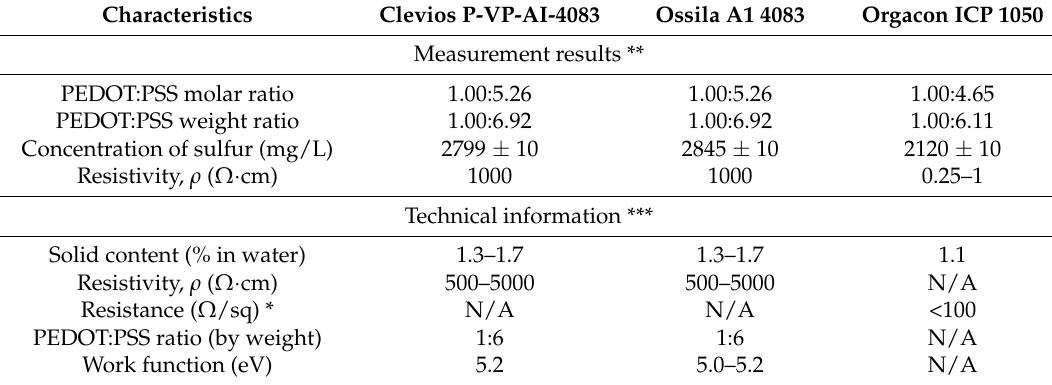
Table 2. PEDOT:PSS physical and chemical characteristics based on measurement (NMR and ICP-OES) and technical